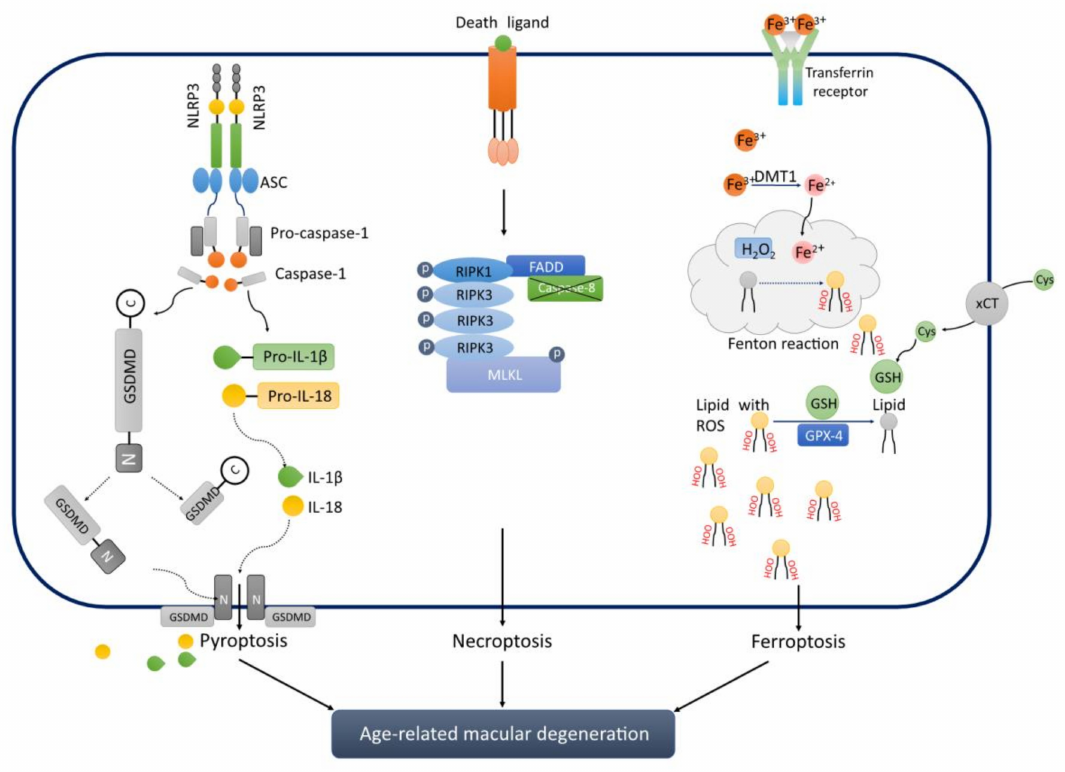
Figure 2. A schematic diagram of the association between novel programmed cell death and